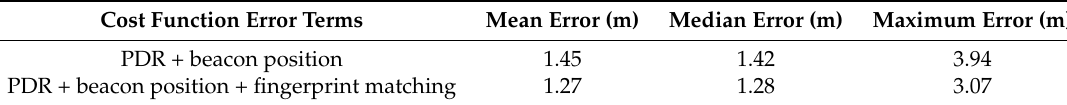
Table 2. Some of the statistics of the beacon position errors for dense beacons situation.